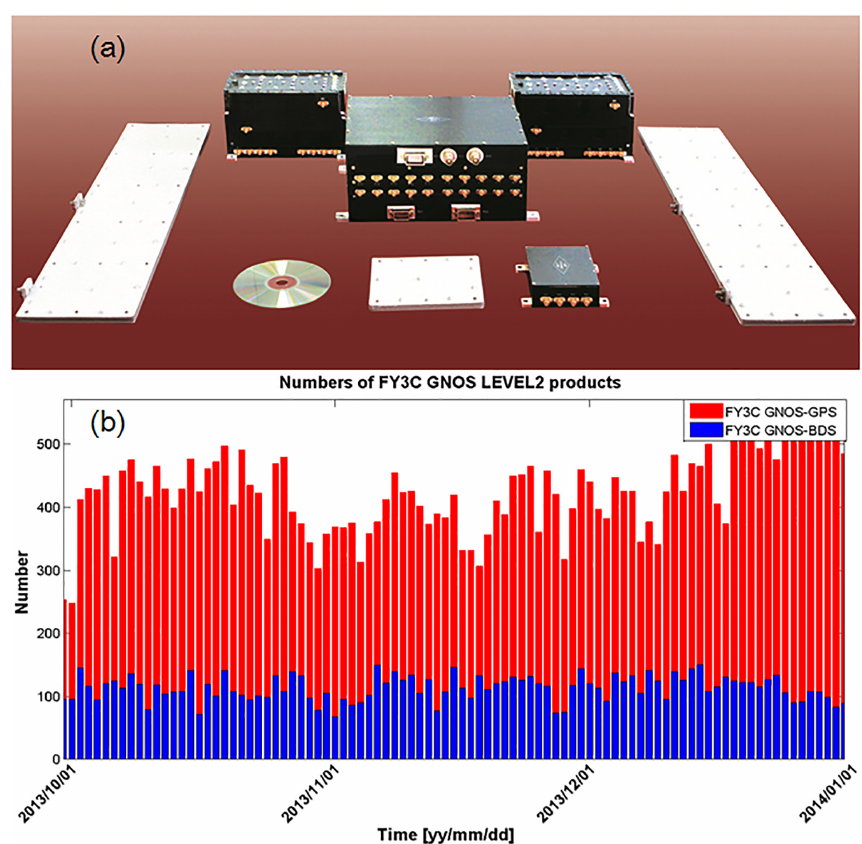
Figure 1. Components of the GNOS instrument (setting/rising occultation antenna and RF unit, left/right; navigation antenna and RF unit, middle in front; tracking and data processing unit, middle in back) (a) , and illustration of the daily number of high-quality FY-3C GNOS GPS and BDS RO events for October–December 2013 as used in this study (b)